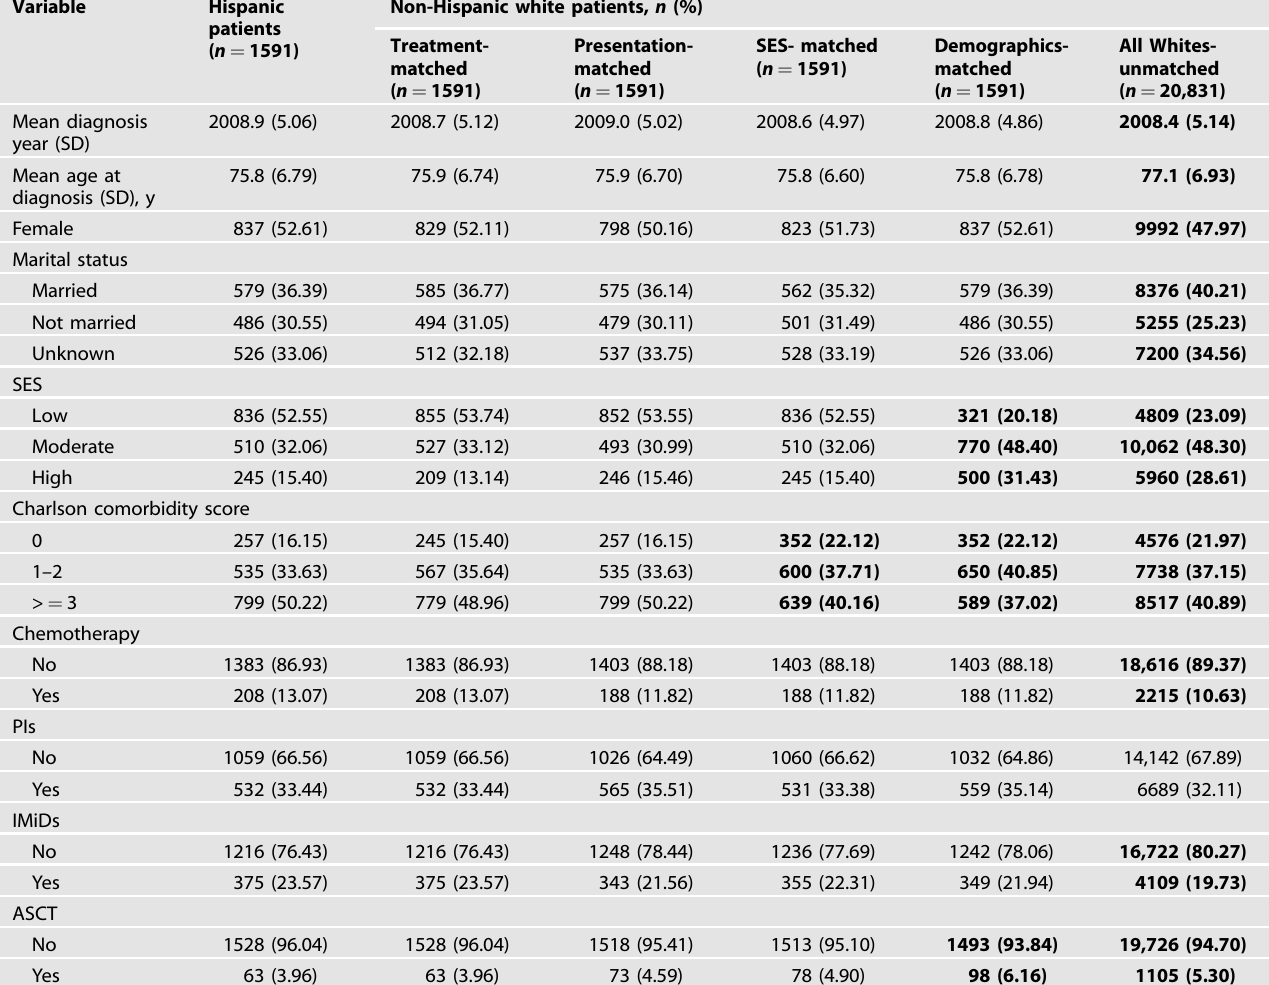
Table 1. Characteristics of hispanic and non-hispanic white